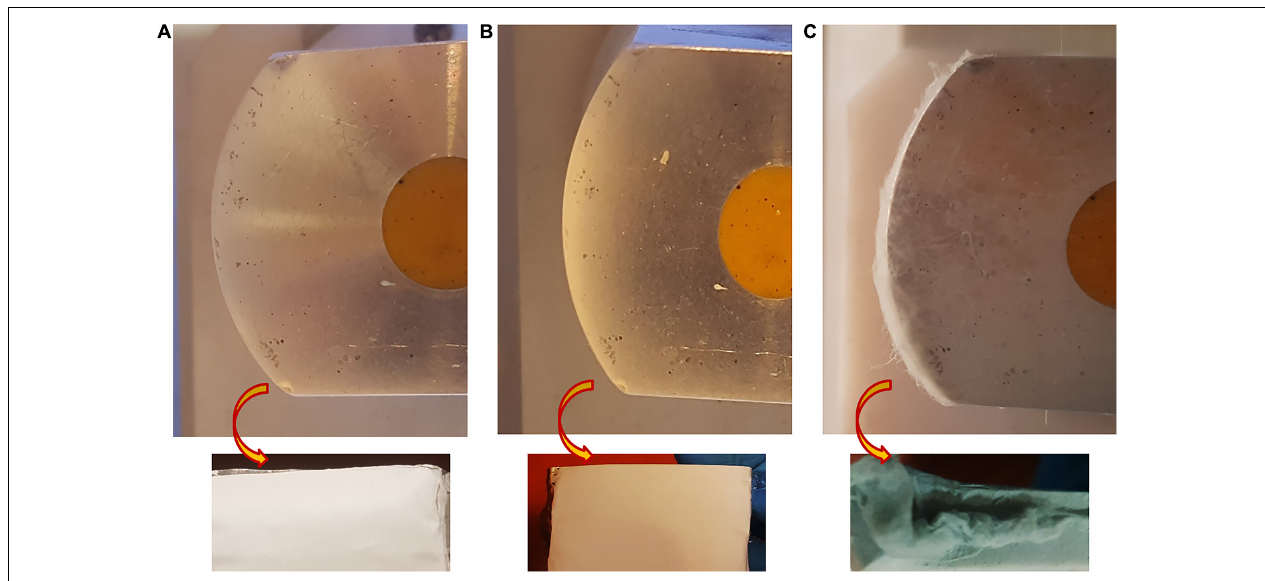
FIGURE 3 | Digital photograph of nanofibers deposited on the collector. (A) PPC/NMP/23%, (B) PPC/DMSO/23%, (C) PPC/HFIP/9% (After 2 h of electrospinning). The images above are of nanofibers deposited on the collectors from the side view. The images below are of nanofibers isolated from the collectors from the top view.